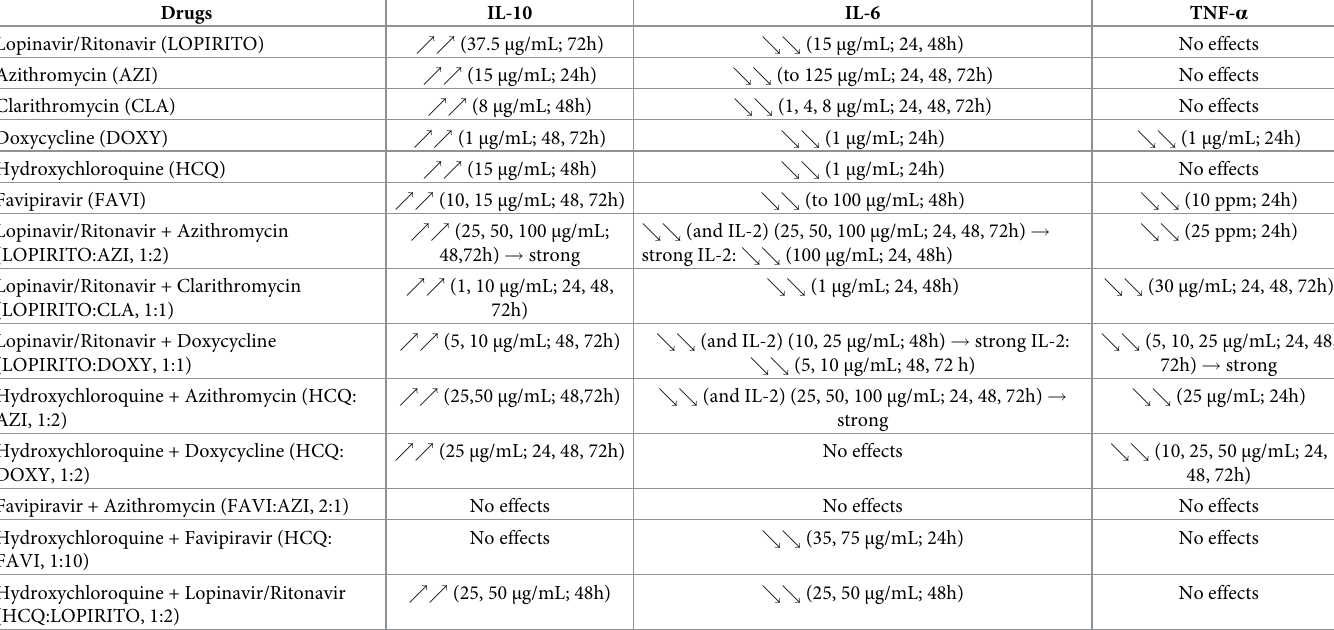
The results indicate that drug combinations demonstrated greater effectiveness in reducing the amount of virus where IC values decreased after 24, 48 and 72 hours of the incubating of 50 cells infected with the drug. As a combination drug, there was a decrease in the number of cop- ies of the virus in some samples whereas, depending on the incubation time of the drug in the sample, there was a significant reduction in the amount of virus in the test group. Table 5. The summary of the cytokine levels of Vero cells infected with SARS-CoV-2 isolates an multiplicity of infection (MoI) value of 0.04 at 24, 48, and 72 hours incubated with single and drug combinations. The data were in duplicates.